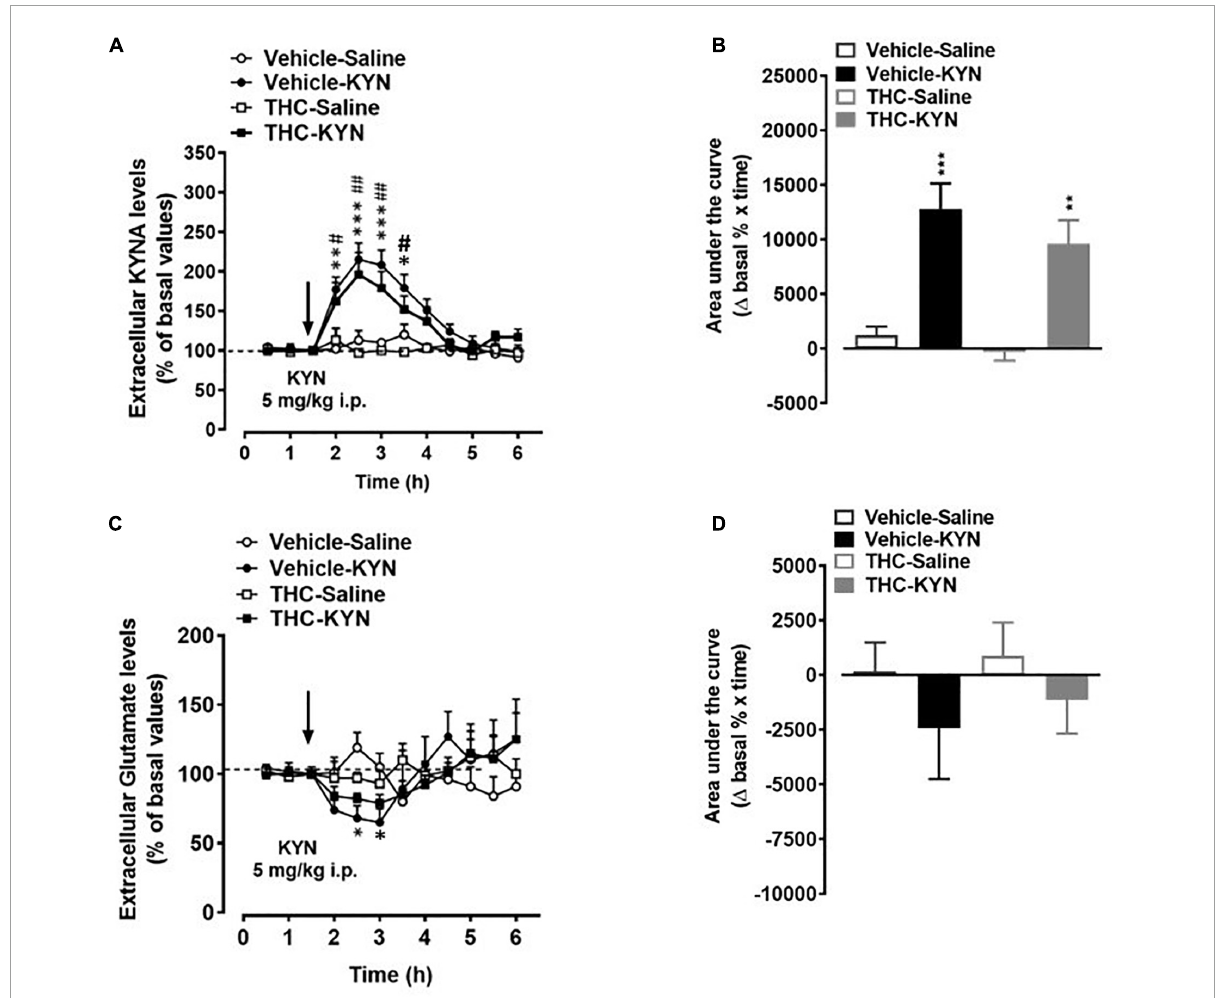
FIGURE5 Extracellular kynurenic acid (KYNA; panel A,B ) and glutamate (panel C,D ) levels in the medial prefrontal cortex of adult [post-natal day (PND) 75] male rats chronically exposed to delta 9-tetrahydrocannabinol (THC) or its vehicle (cremophor and saline 1:1:18; vehicle). Ascending doses of THC or its vehicle were administered by i.p. to adolescent rats, from PD 35 to PD 45. (A,C) Data mean ± standard error of the mean (SEM) are expressed as a percentage of the averaged three baseline values prior to treatment. (B,D) Bar graphs of the areas under the curves (AUC), calculated as the percentage of changes in basal values over time. Data were analyzed by three-way (A,C) or two-way (B,D) ANOVA and subsequent Tukey’s post hoc test for multiple comparisons. (A) * p < 0.05, ** p < 0.01, *** p < 0.001 Vehicle KYN vs Vehicle-Saline and THC-Saline; # p < 0.05, ## p < 0.01 THC-KYN vs Vehicle-Saline and THC-Salina; (B) *** p < 0.001 Vehicle-KYN vs Vehicle-Saline and THC-Saline; ** p < 0.01 THC-KYN vs Vehicle-Saline and THC-Saline. (C) * p < 0.05 Vehicle-Saline vs Vehicle-KYN and THC-Saline; n = 5/6 male